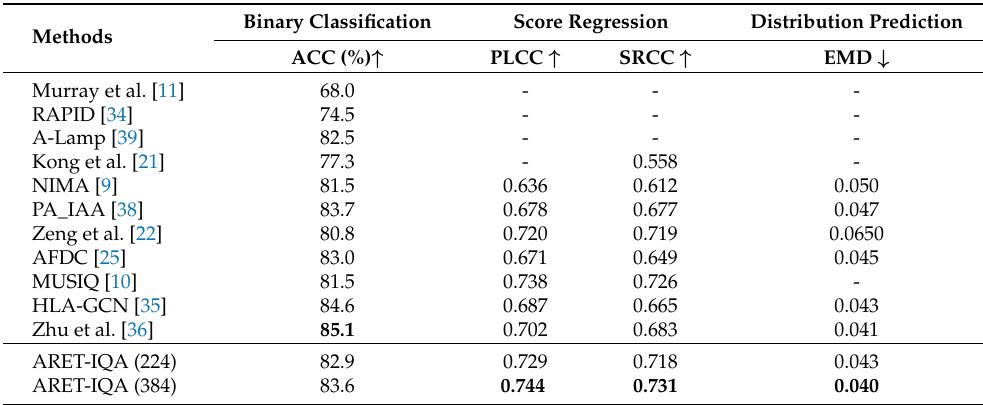
Table 3. Performance comparison with several representative IQA methods on the AVA database [11]. The best results are highlighted in bold font and “-” denotes unreported results. In our ARET-IQA model, the input images were resized to two default resolutions for the Transformer network: 224 × 224 (ARET-IQA (224)) and 384 × 384 (ARET-IQA (384)).